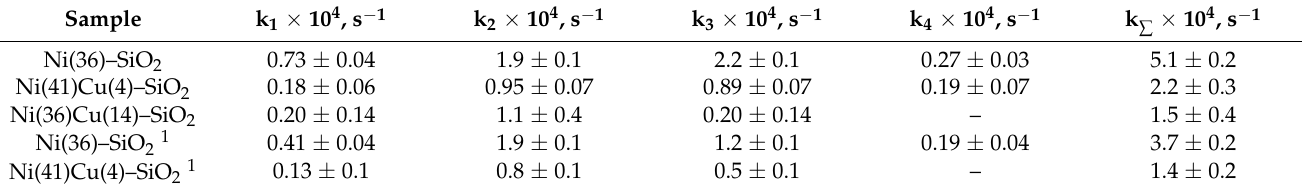
Table 2. Rate constants of product formation in the experiments at 250 ◦ C. The constants were calculated using the least squares method, m(catalyst) = 0.10–0.11 g.